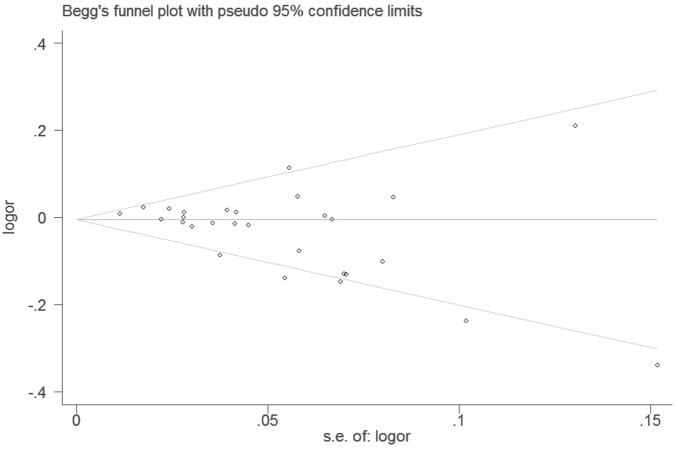
Begg’s funnel plot with pseudo 95% confidence limit under the additive genetic model of 1298 A>C genotype.